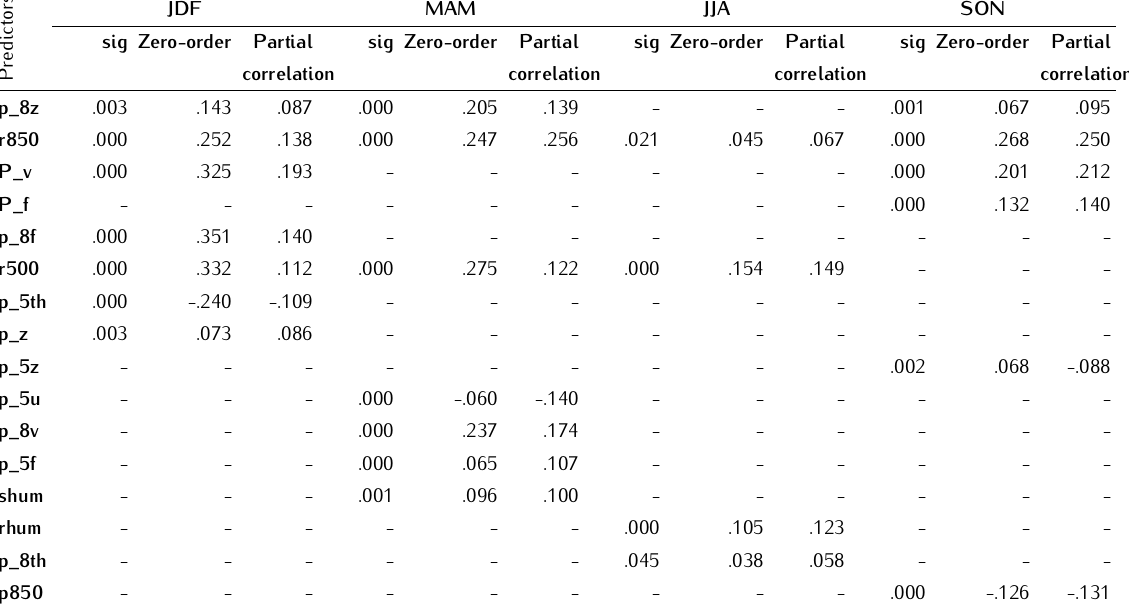
Table 1. Definition of the selected climate variable.